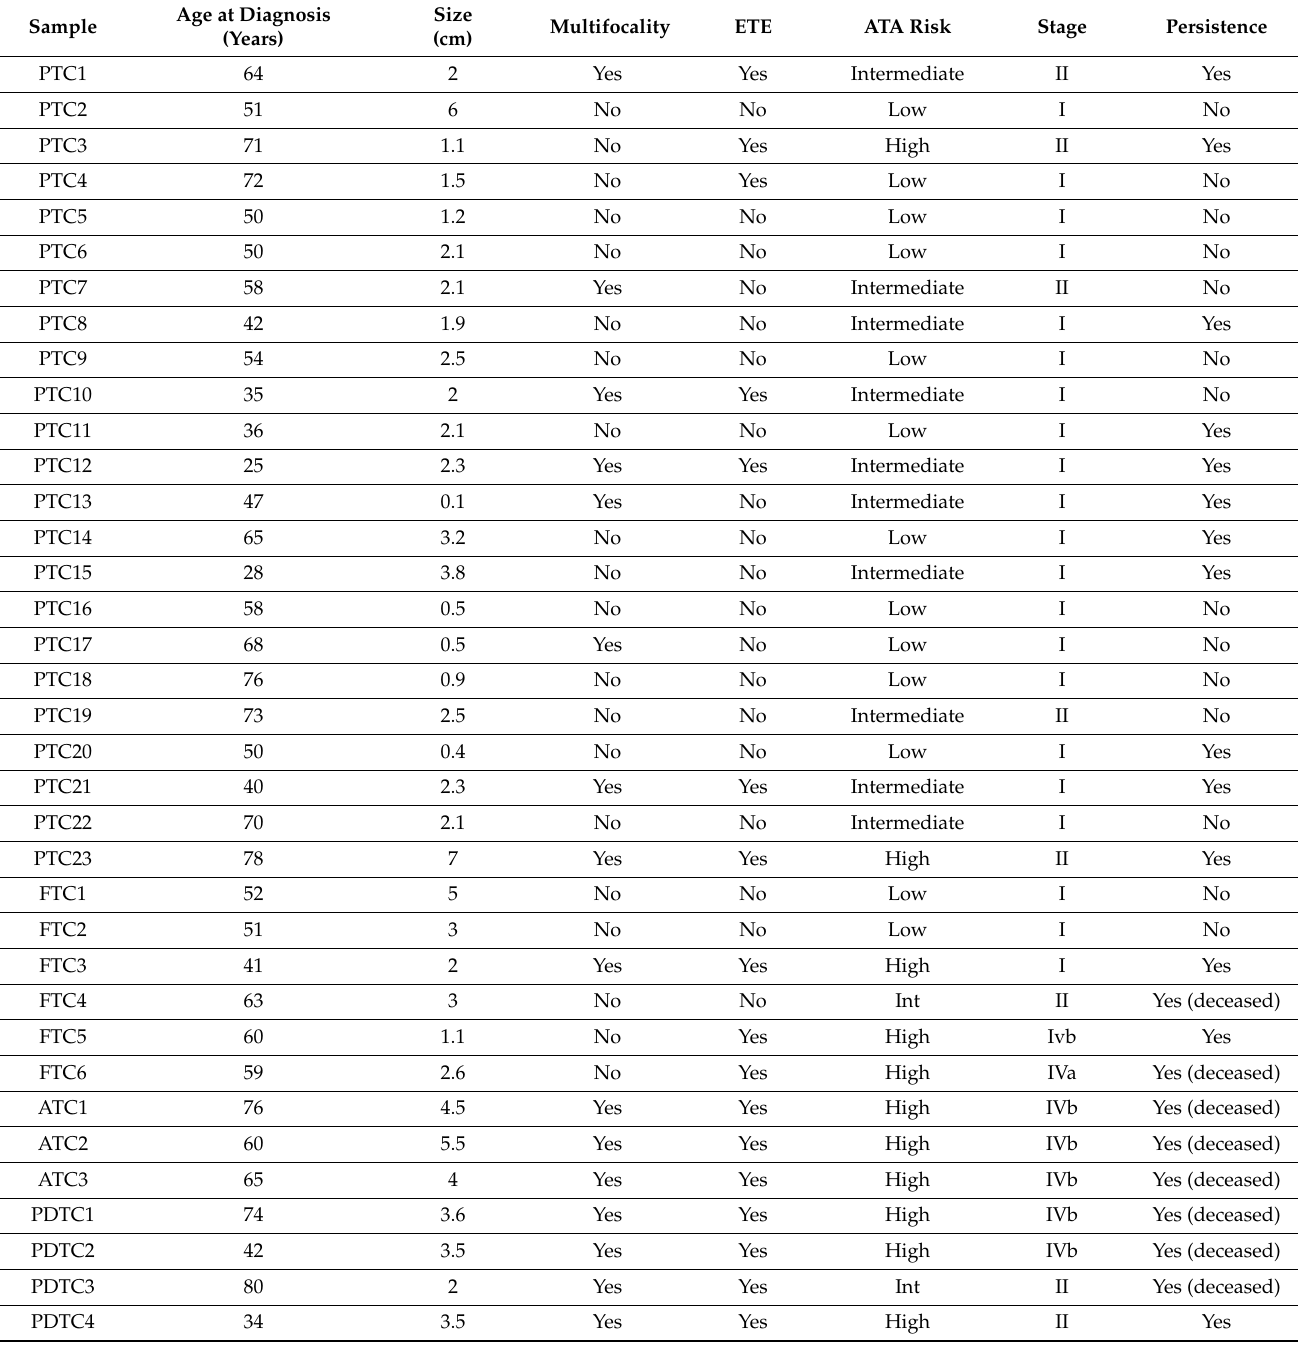
Table 1. Clinical-prognostic features of the